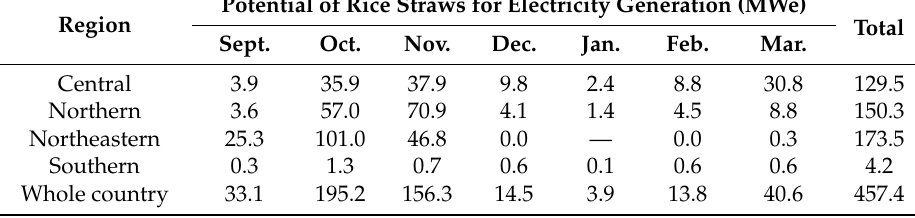
Table 5. Potential of rice straws for electricity generation in Thailand classified by region and harvesting